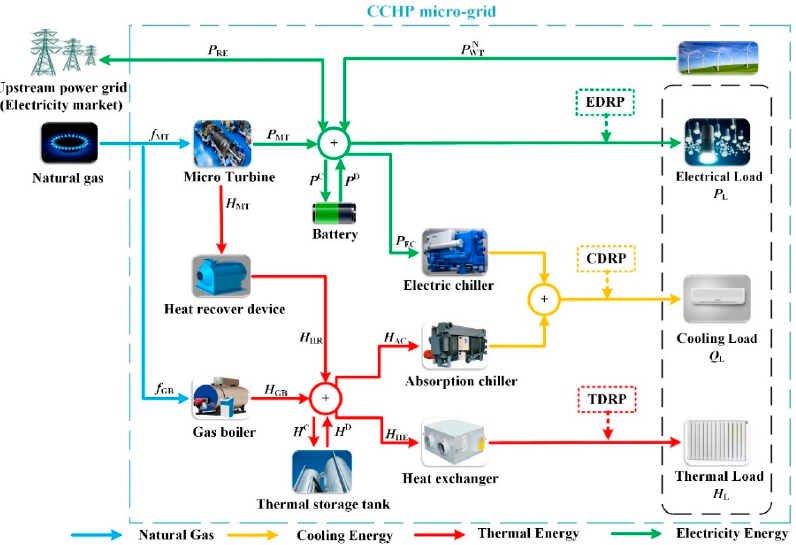
Figure 1. Schematic of a combined cooling, heating and power (CCHP) micro-grid.